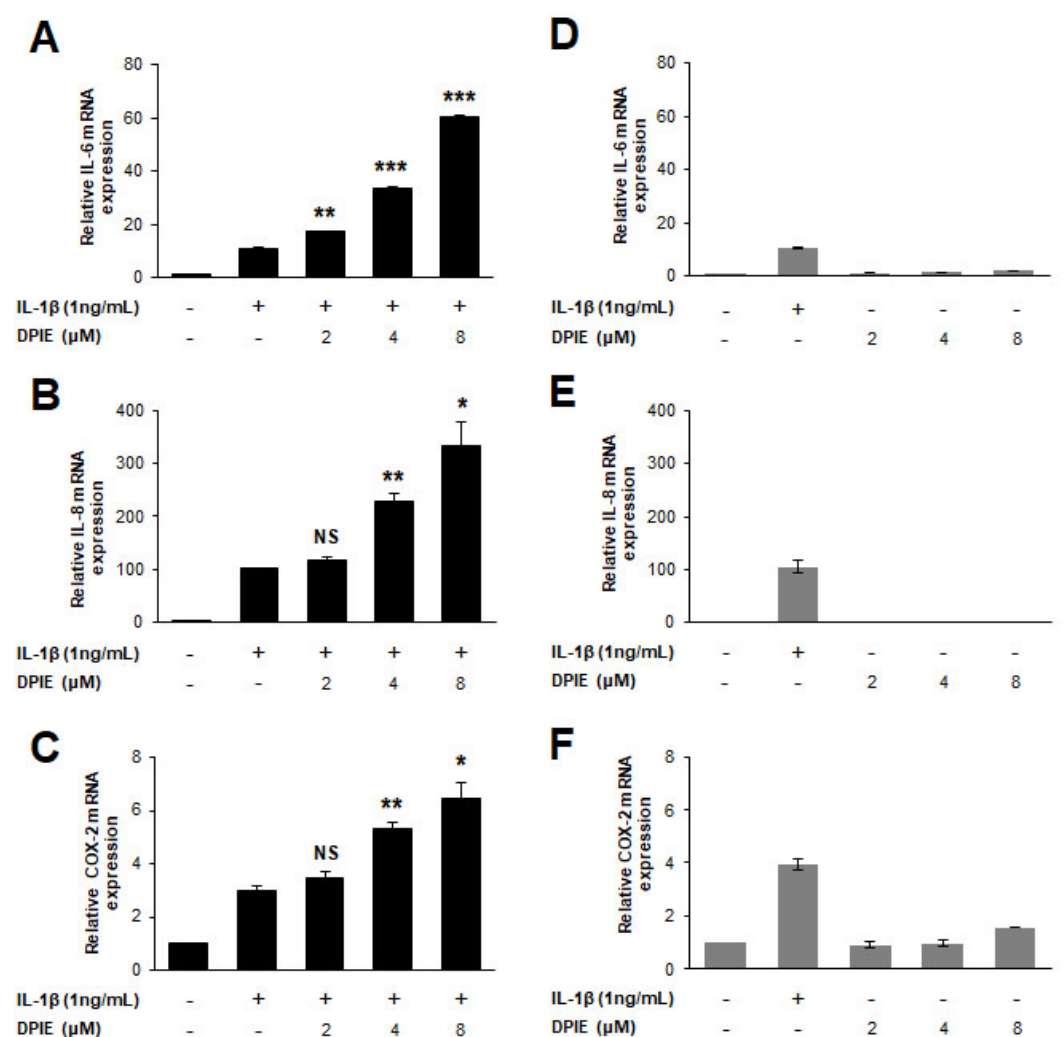
Figure 2. DPIE enhances pro-inflammatory cytokine expression in IL-1 β -stimulated hGFs. hGFs were treated for 12 h with 0, 2, 4, or 8 µ M DPIE in the absence or presence of 10 ng/mL IL-1 β . ( A – C ) Concentration-dependent enhancing effects of DPIE on IL-6, IL-8, and COX-2 mRNA in IL-1 β -stimulated hGFs. ( D – F ) The effect of DPIE alone on IL-6, IL-8, and COX-2 mRNA in hGFs. * p < 0.05, ** p < 0.01, *** p < 0.001, and NS: not significant compared with IL-1 β alone (unpaired two-tailed Student’s t tests).